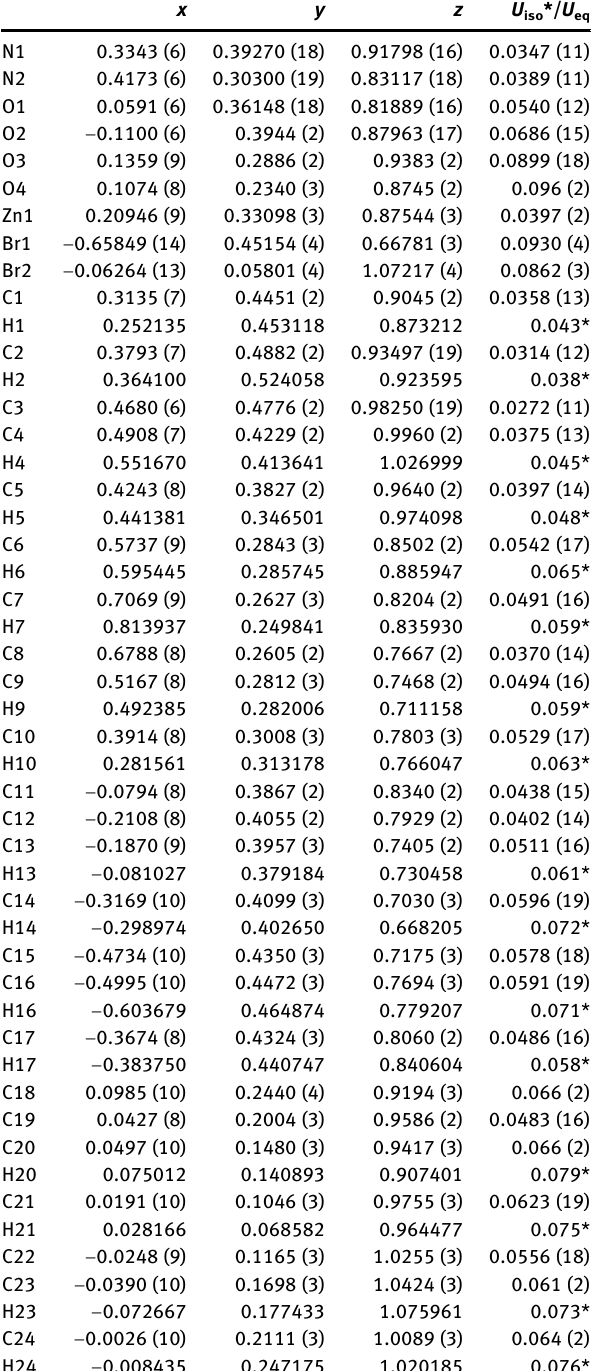
the figure). The Zn — O bond lengths are in the range of